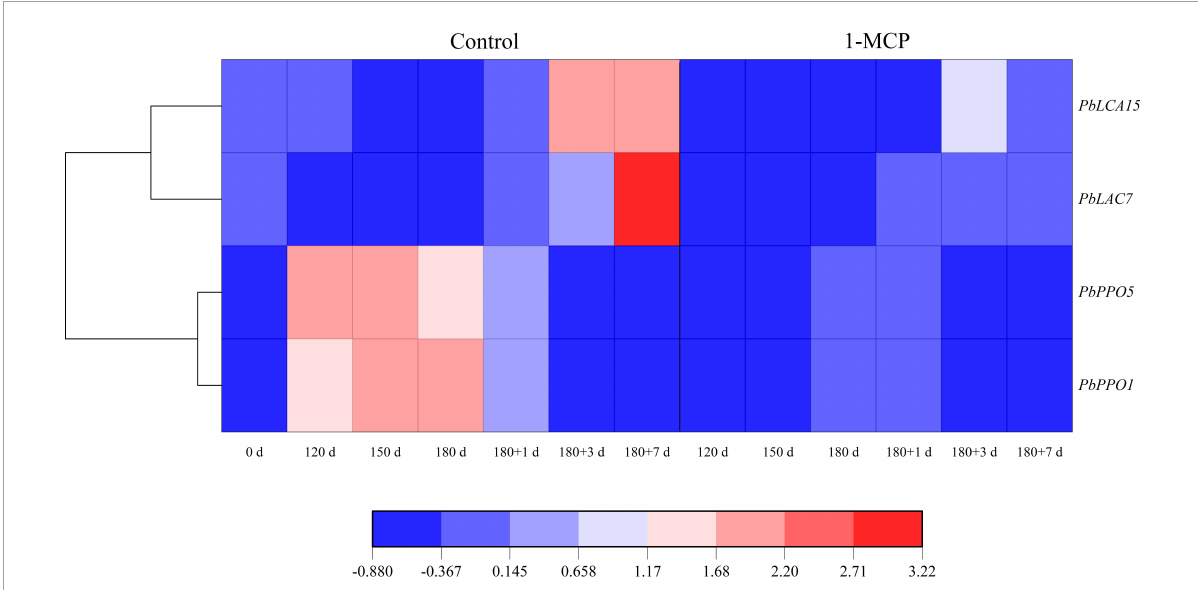
FIGURE6 Effect of 1-MCP on the expression profiles of PbPPOs and PbLACs in the peels of “Yali” pear. 180 + 1, 180 + 3, and 180 + 7 indicated Days 1, 3, and 7 at shelf life after 180 days of cold storage, respectively.